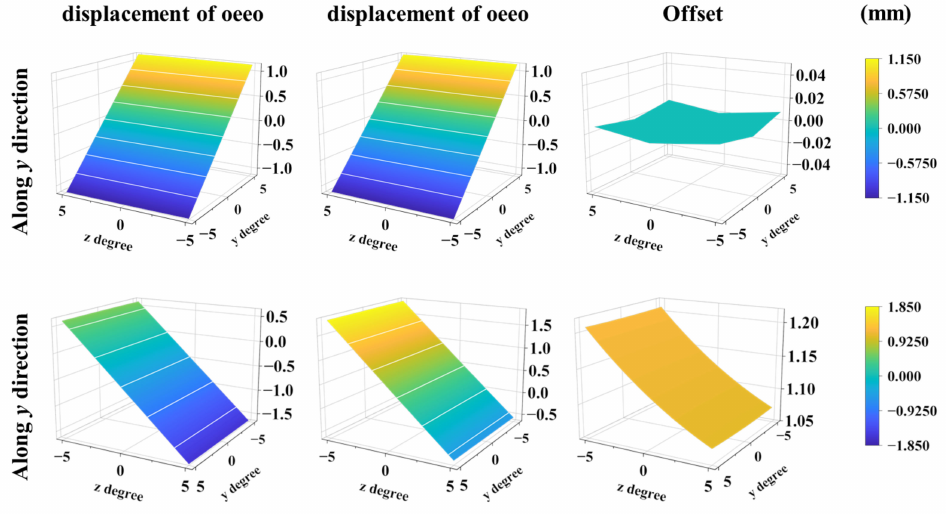
Figure 4. Spatial distribution of offset and